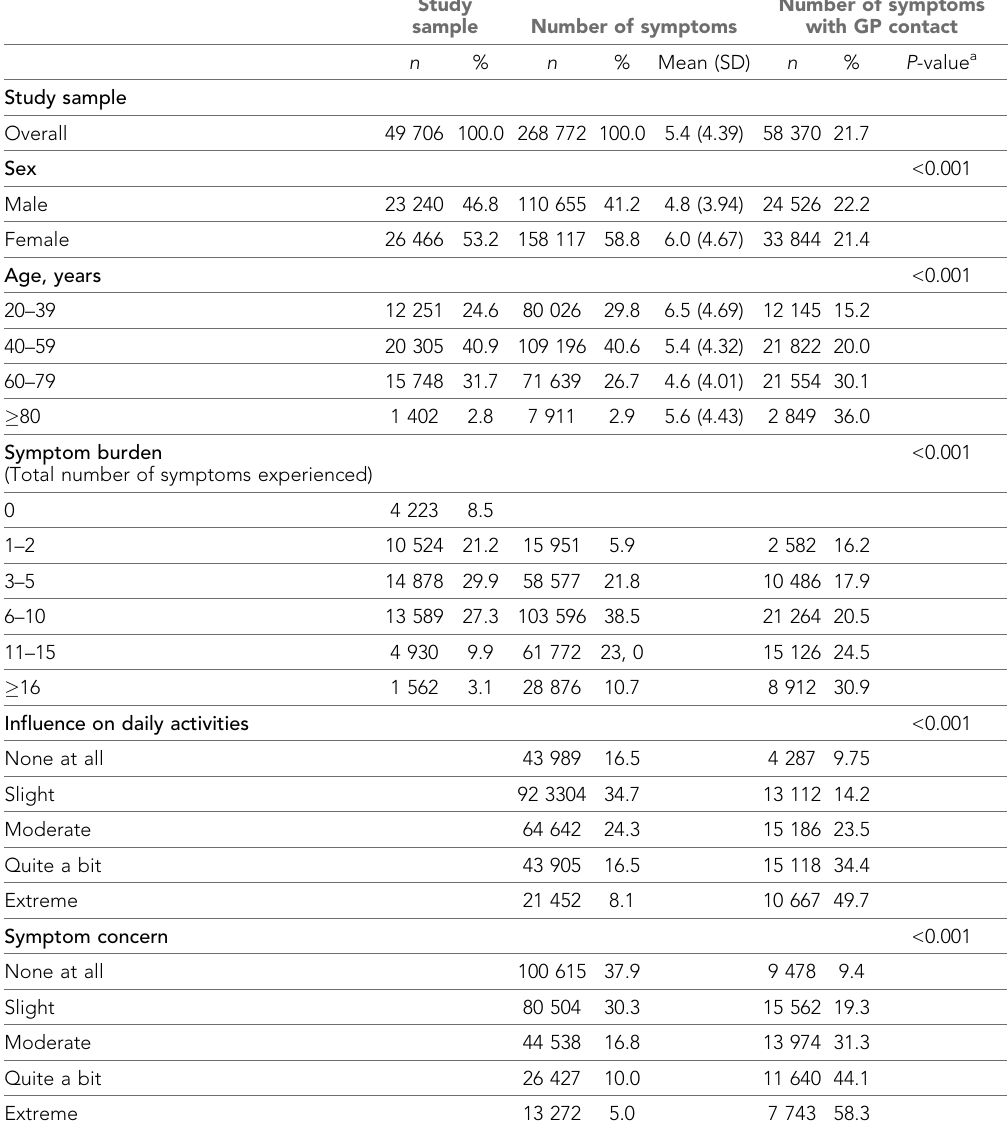
Table 1. Characteristics of study sample with regard to symptoms and GP contact